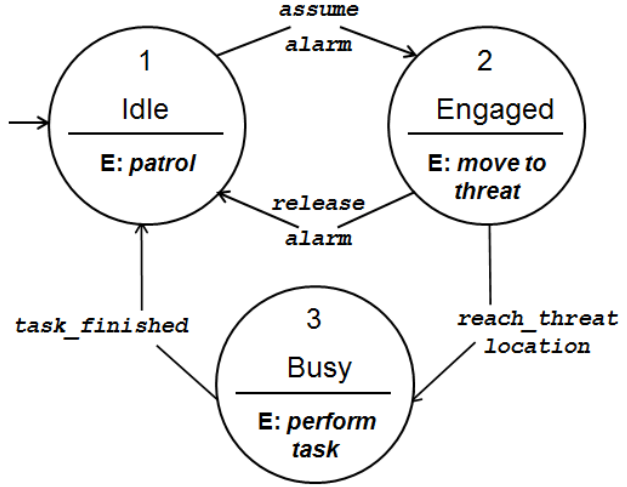
Figure 3. Finite state machine for unmanned aerial